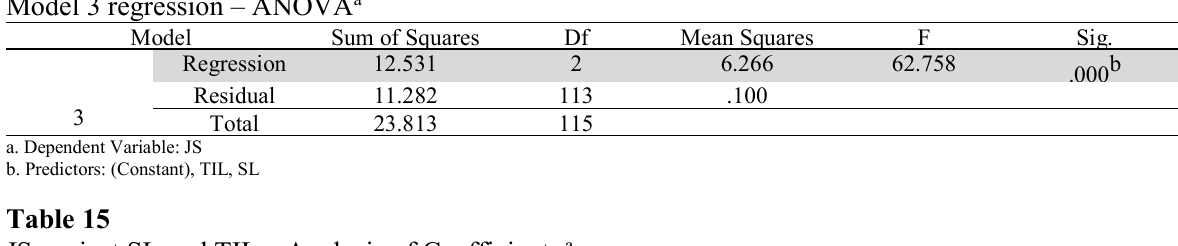
JS against SL and TIL – Analysis of Coefficients a Unstandardized Coefficients Standardized Model